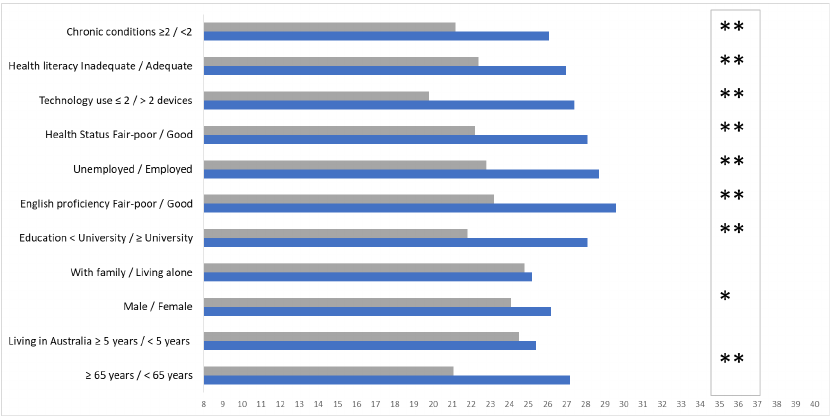
Table 3. Predictors of eHealth literacy of Chinese immigrants (adjusted) *.